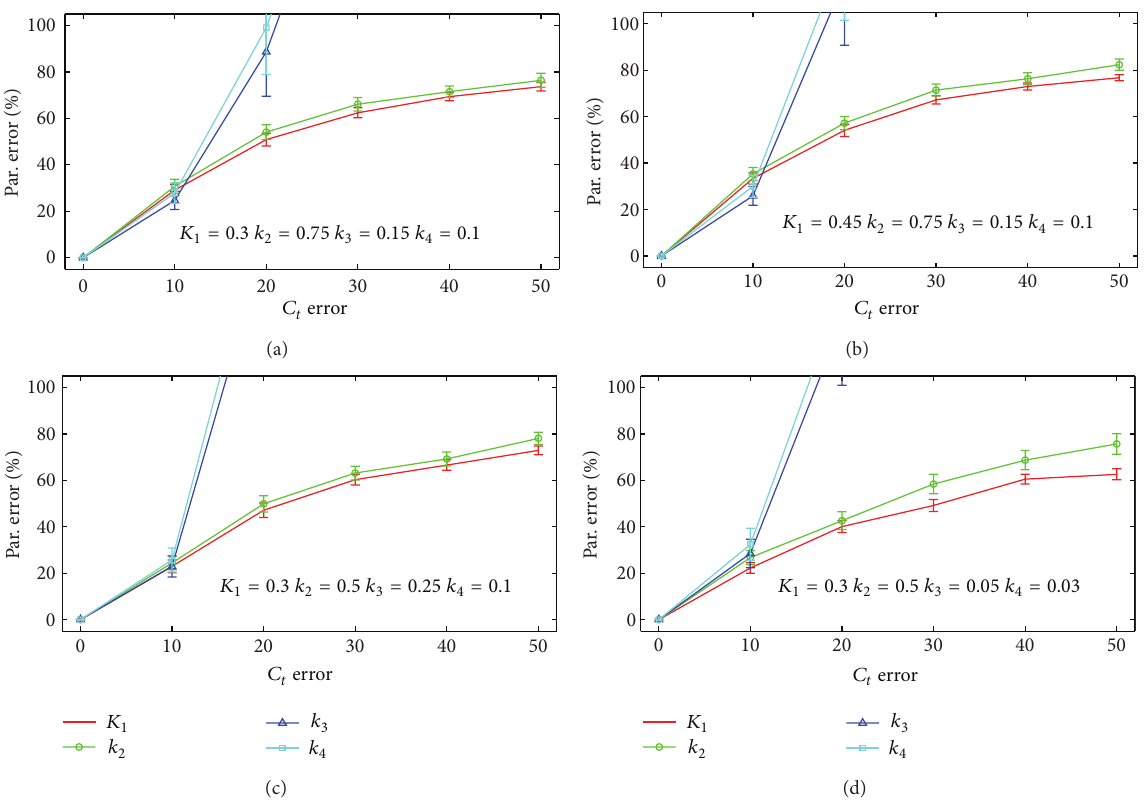
Figure 4: The error in the estimated PET kinetic parameters as a function of the noise in the tissue curves. Each panel corresponds to a different set of PET kinetic parameters. For each set of parameters, when the error in 𝐶 𝑡 is less than 10 times the square root of the activity level, the parameter error is less than 50. As the error in 𝐶 𝑡 continues to increase, the error in 𝑘 3 and 𝑘 4 increases rapidly. The error in 𝐾 1 and 𝑘 2 also continues to increase, but less